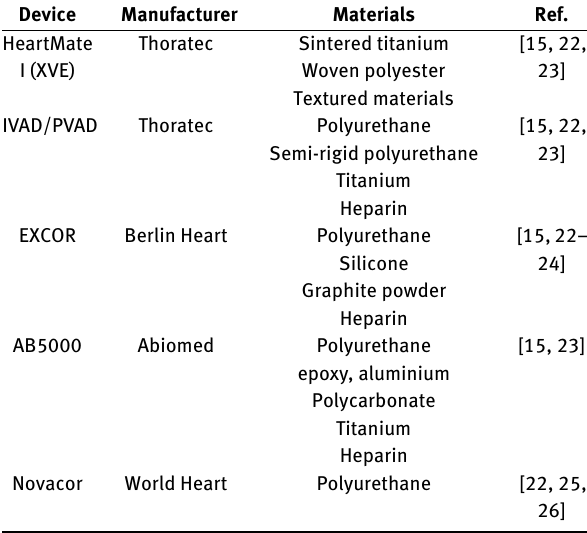
Table 1: The clinical pulsatile implantable heart